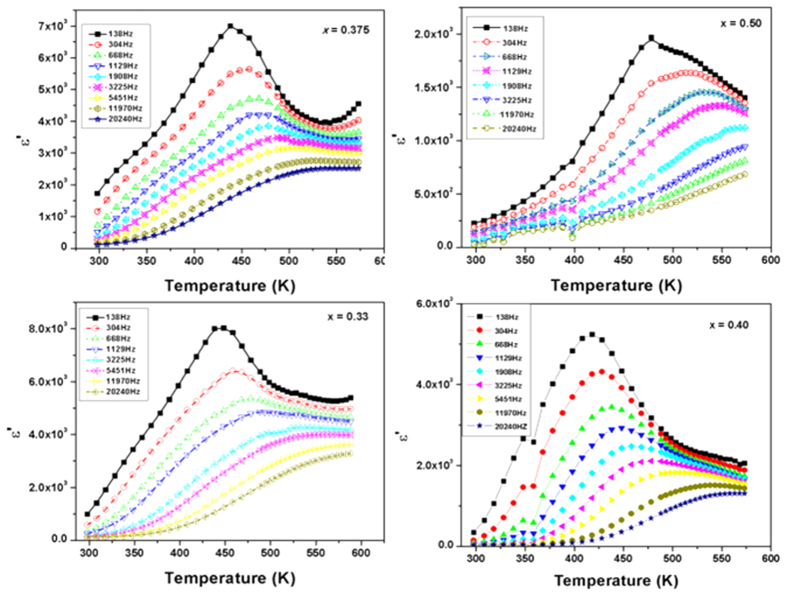
Variation of real part of relative permittivity with temperature for orthorhombic solid solution phases in SrTi1−2xFexTaxO3 system (x = 0.33, 0.375, 0.40 and 0.50).Solid lines are guide to the eye.